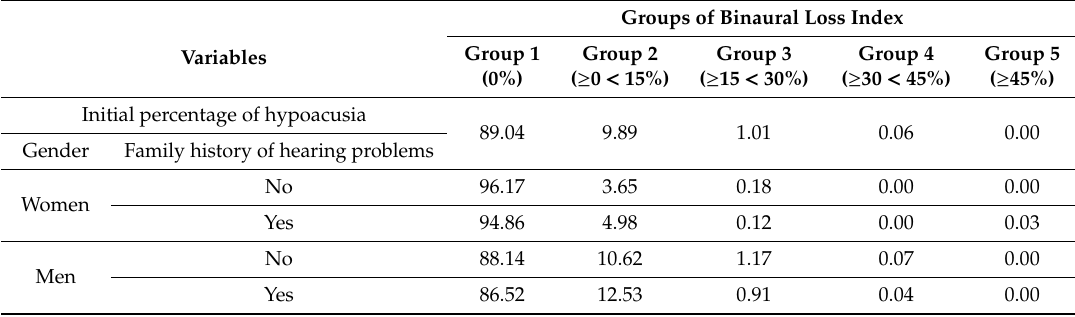
Table 6. Sensitivity analysis. Gender and family history of hearing problems vs. Binaural Percentage Index. Source: Compiled by authors.